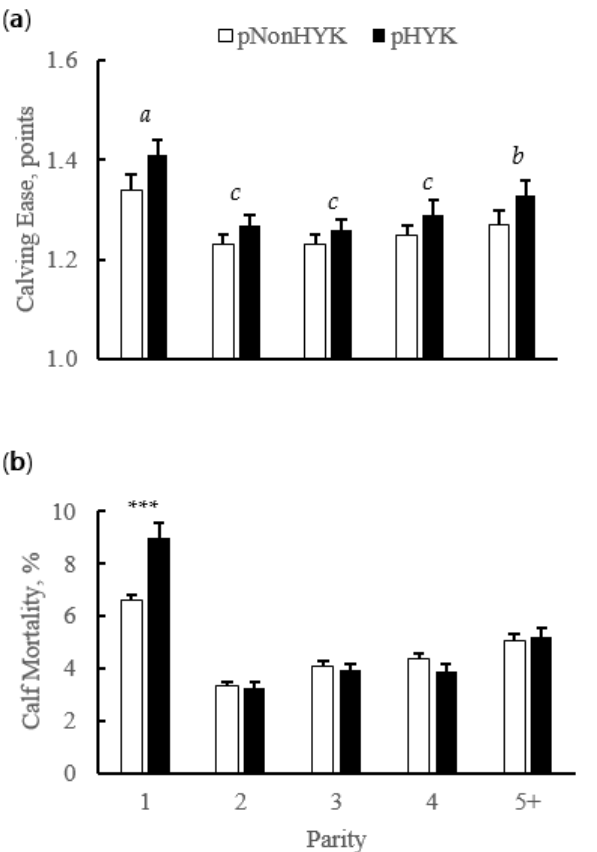
Figure 3. Effect of parity, predicted hyperketonemia (HYK) status, and the interaction on ( a ) calving ease (points); and ( b ) calf mortality (%). Blood ß-hydroxybutyrate (BHB) was predicted based on test day milk sample and production variables collected between 5 to 20 days in milk. Predictions were classified as predicted HYK (pHYK; predicted BHB ≥ 1.2 mM) or not (pNonHYK; predicted BHB < 1.2 mM) for analysis. Records per lactation: 1, 88,782; 2, 67,327; 3, 43,790; 4, 23,999; 5+, 16,816. Panel ( a ): predicted HYK, p < 0.001; parity, p < 0.001, differing superscript letters ( a , b , c ) indicate differences between parities; parity by predicted HYK interaction p = 0.48. Panel ( b ): predicted HYK, p = 0.25; parity, p < 0.001; parity by predicted HYK interaction, p = 0.002, asterisks (***) indicate simple effect of classification ( p < 0.001) within parity.